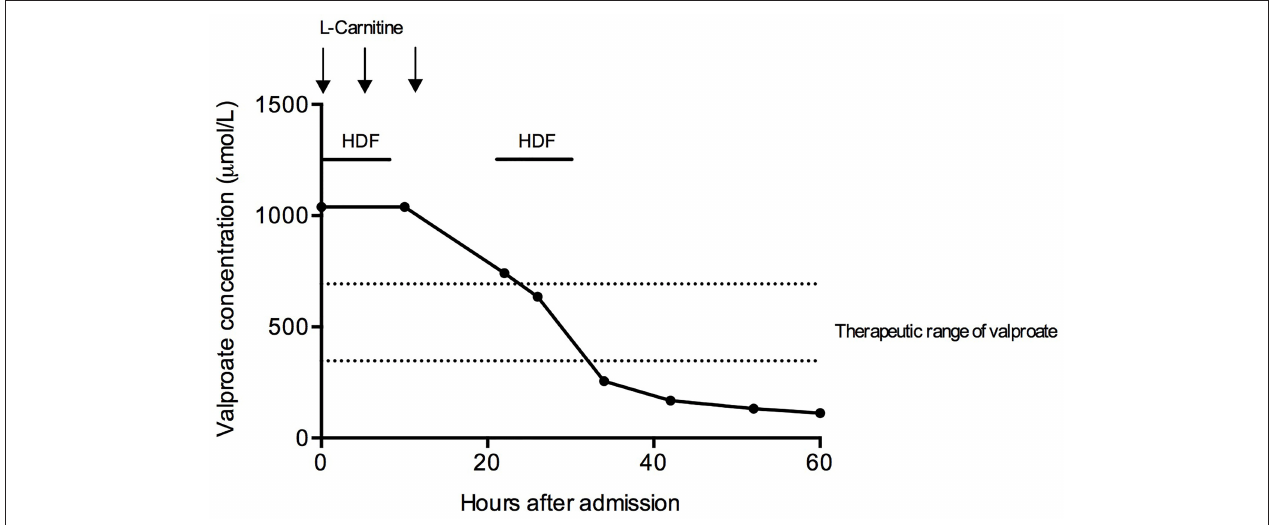
FIGURE 1 | Treatment course of the patient. Hemodiafiltration and L-carnitine infusions were initiated on admission. Two hemodiafiltration sessions of 12-h duration were initiated. HDF,